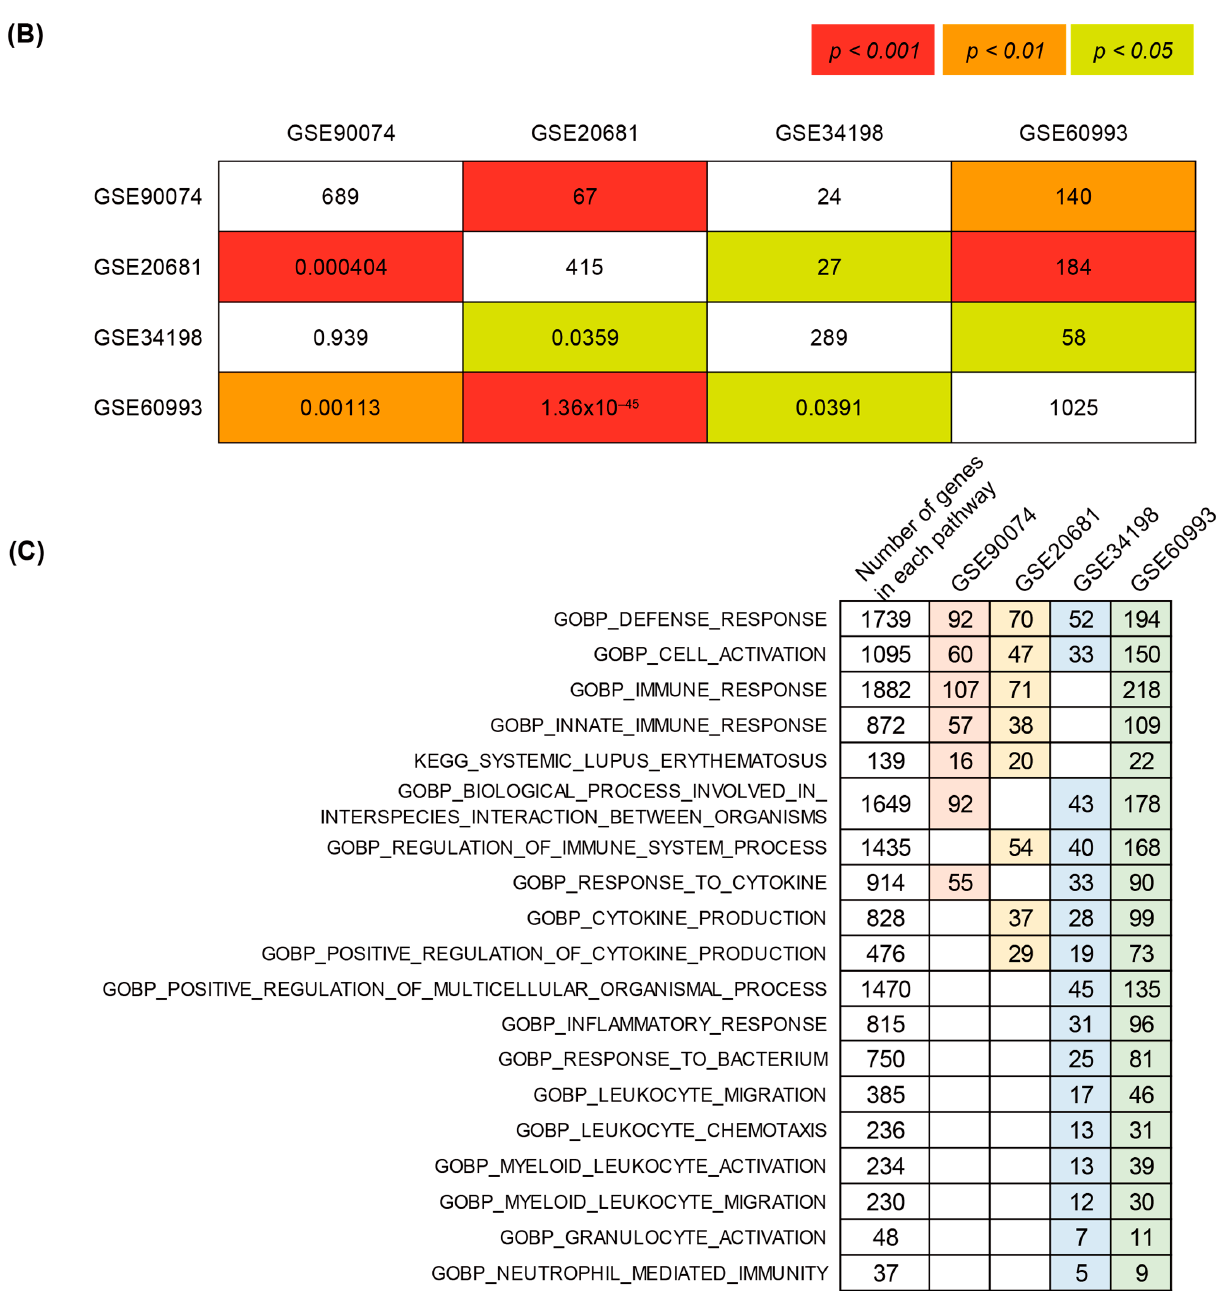
Figure 2. Comparison of disease-related transcriptomic signature among four blood CVD datasets. ( A ) Correlation matrix among four gene expression datasets. Distributions located on the diagonal are expression values for all genes. Each point indicates a gene Y and X axes are logFC between the two statuses described in the form of (A/B). A scatter plot in the xth row and yth column indicates the correlation between xth and yth datasets of diagonal datasets. Its correlation coefficient is described on the xth column and yth row. ( B ) Numbers in upper triangle matrix indicate the number of common genes between each of the four sets of DEGs between two conditions. Their matched p - values measured by hypergeometric test are located in lower triangle matrix. ( C ) Biological pathways were based on hypergeometric test described in Materials and Methods. Numbers within rectangles indicate numbers of DEGs or possible DEGs in each pathway. Abbreviations: CVD, cardiovascular disease; FC, fold change; PCC, Pearson’s correlation coefficient; SCC, Spearman’s correlation coefficient; DEG, differentially expressed gene.